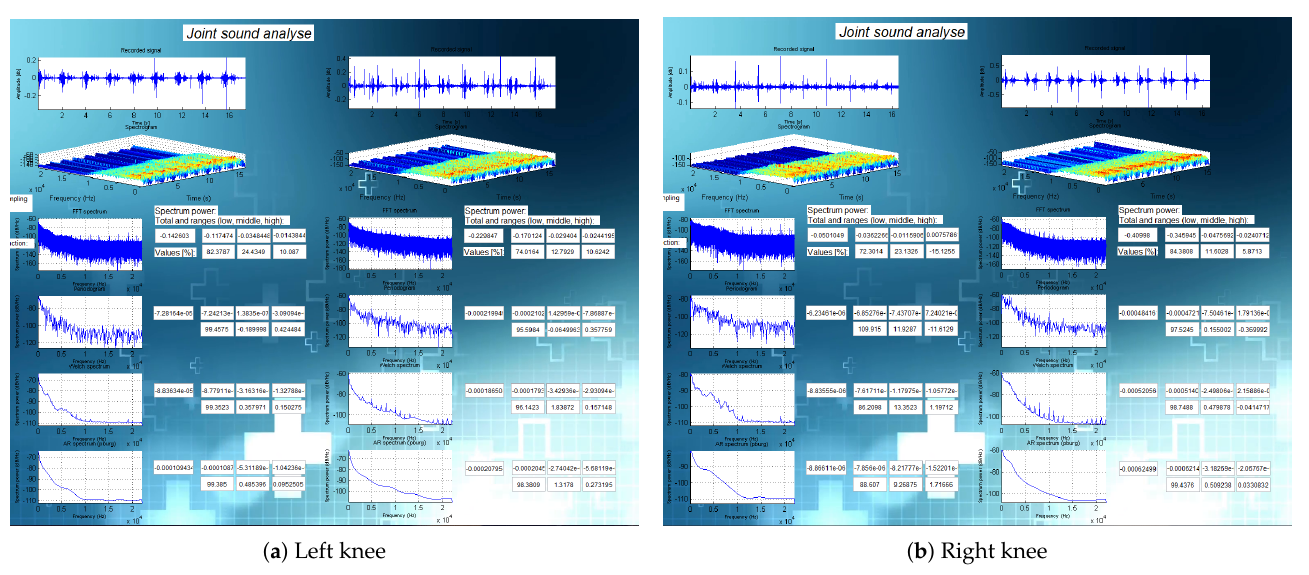
Figure A11. Analysis for subject